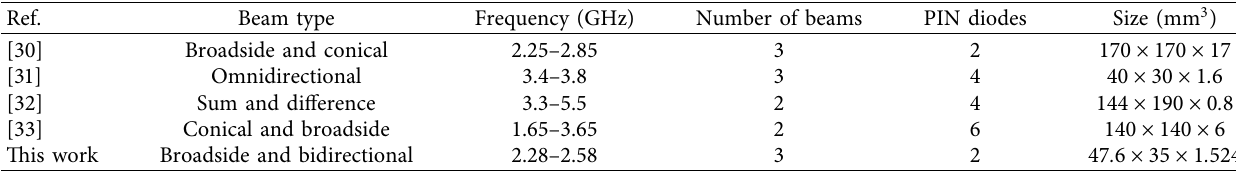
Table 3: Comparison of the proposed